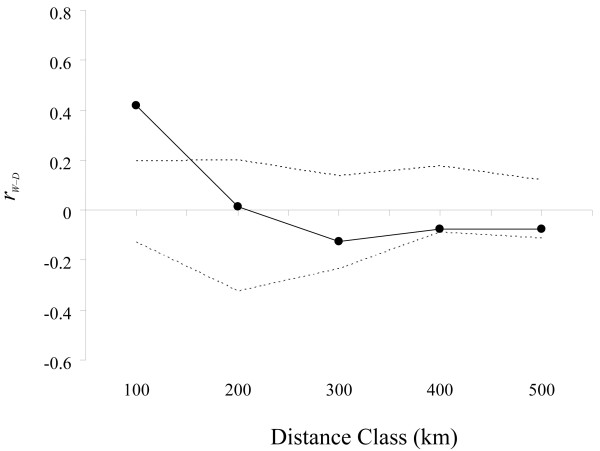
Autocorrelation analysis. Autocorrelation analysis of wild-domesticated pairs of populations (rW-D) performed on asymmetrical distance matrices. Plot of the genetic autocorrelation coefficient as a function of the geographical distance classes; dotted lines define the 95%-confidence interval based on 999 permutations.